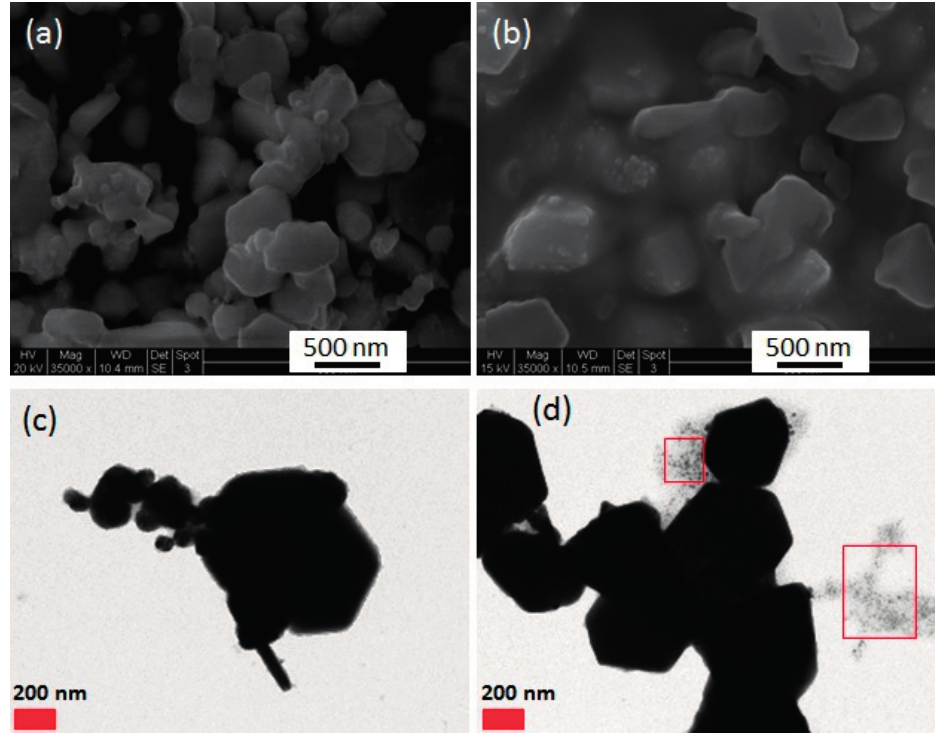
Figure 4. SEM ( a , b ), and TEM ( c , d ) images of synthesized Ag; samples with the present method: ( a , c ) for Ag sample MW-heated for 3 min, and ( b , d ) for Ag sample irradiated for 6